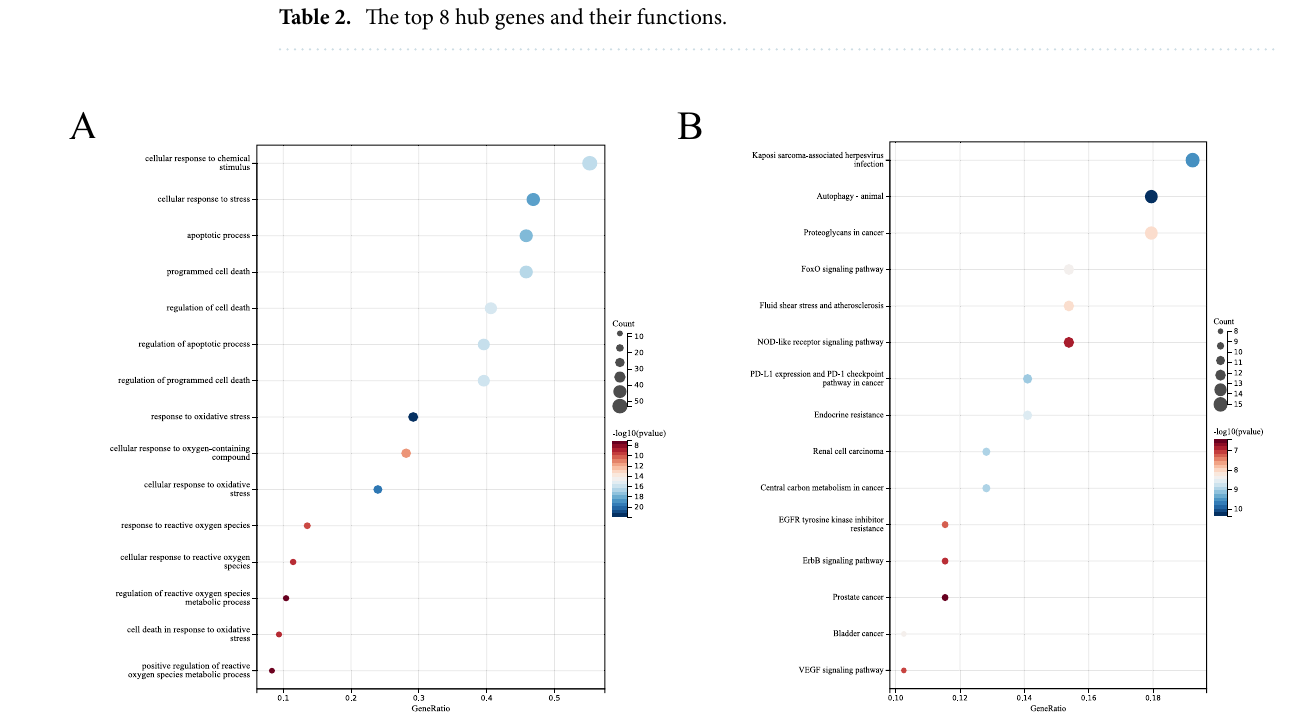
Figure 3. GO and KEGG enrichment analysis of DE-FRGs related to LN. ( A ) Bubble plot of enriched GO terms showing DE-FRGs. ( B ) Bubble plot of enriched KEGG pathways showing DE-FRGs. A darker color and a larger bubble denote a more significant